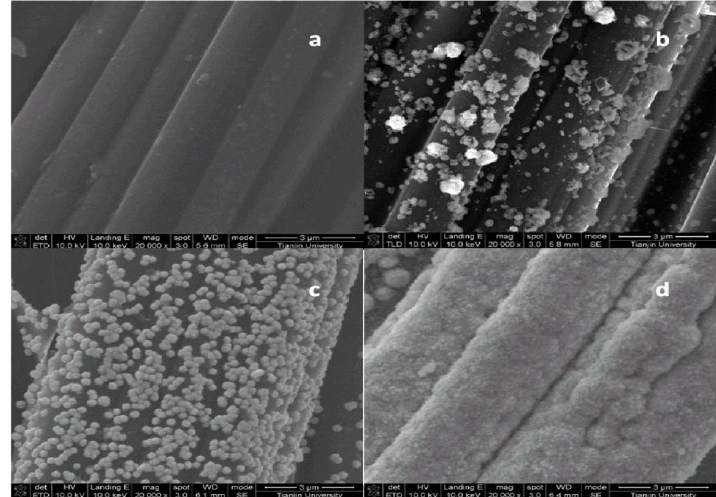
Figure 1. Scanning electron microscopy (SEM) images of the surface of copper oxide-coated carbon cloth. These carbon cloths were modified with deposition times of 0 ( a ), 50 ( b ), 100 ( c ), and 150 s ( d ),